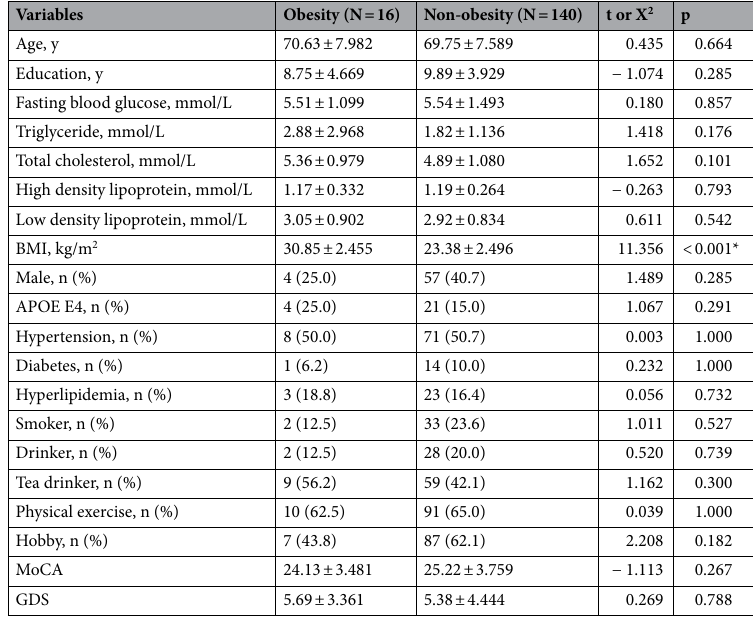
Table 3. General demographic data of the Chinese elderly with normal cognitive function based on obesity. BMI body mass index, MoCA Montreal Cognitive Assessment, GDS Geriatric Depression Scale. *Means p <